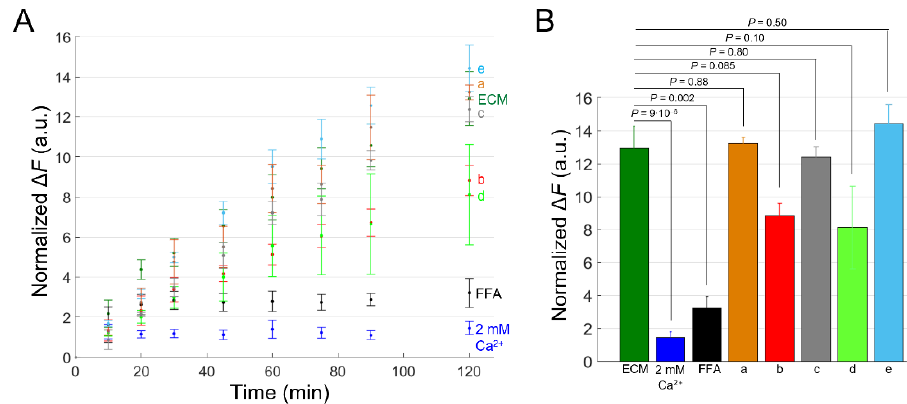
Figure 8. Tests of different anti-Cx46 candidate mAbs by DAPI uptake assay in HaCaT-Cx46- GCaMP6s cells. ( A ) Time course of DAPI uptake assay performed with a plate reader in dox- induced HaCaT-Cx46-GCaMP6s stable pools. Cells were exposed to DAPI (5 µM) dissolved in: ECM (green), ECM supplemented with 2 mM Ca 2+ (blue), ECM plus FFA (100 µM, black), ECM plus Ab17340 (a, 1 µM, orange), ECM plus Ab17396 (b, 10 µM, red), ECM plus Ab17397 (c, 1 µM, gray), ECM plus Ab17398 (d, 0.4 µM, light green) and ECM plus Ab17399 (e, 1 µM, light blue); for each condition, DAPI up take was measured as average fluorescence signal variation Δ 𝐹 = 𝐹(𝑡) − 𝐹 0 of 3 ≤ n ≤ 6 cultures at different time points, from 5 min after the beginning of dye incubation ( t = 0) up to 2 h later. The data are quoted as the mean values ± s.e.m. ( B ) The mean Δ 𝐹 values obtained for each condition shown in ( A ) at the end of the observation time window (2 h); p values ( P ) were calculated using the two-tailed t -test.